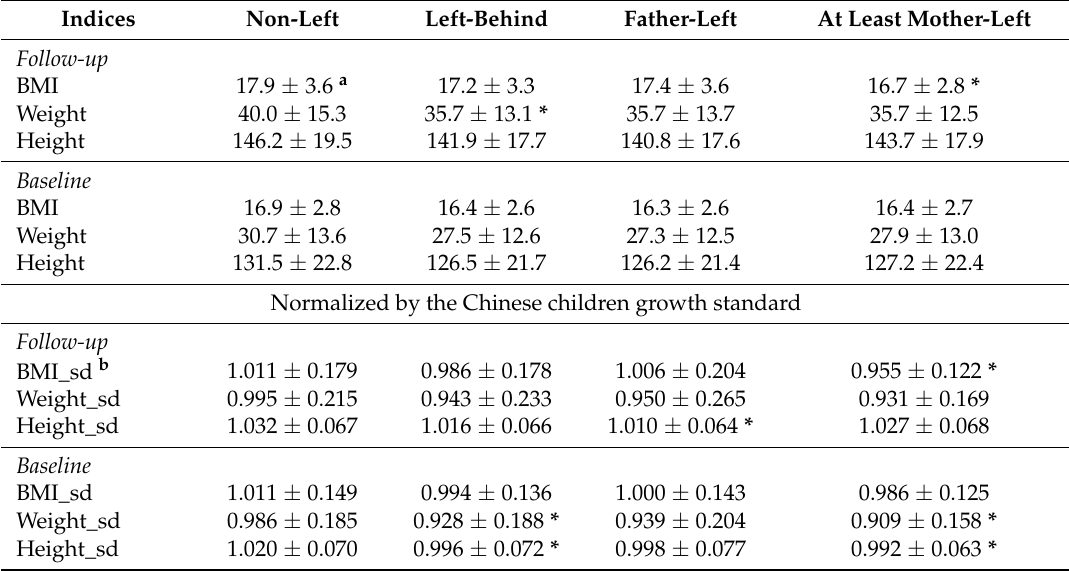
Table 2. Comparison of growth indices for different